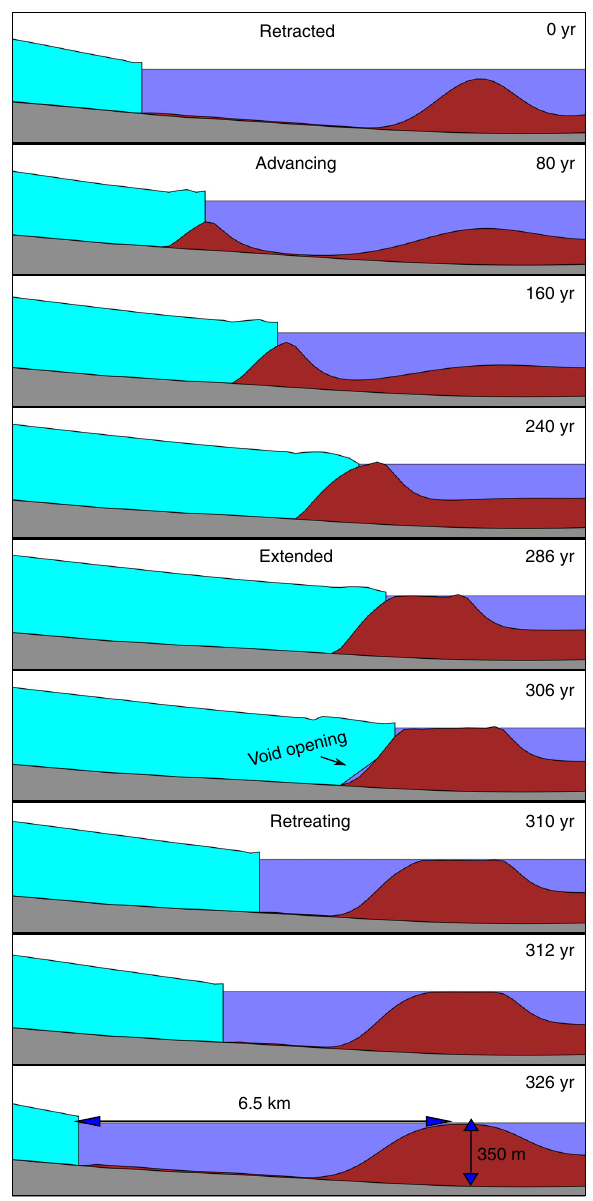
Fig. 3 Modeled glacier geometry through a tidewater glacier cycle. Time period corresponds to the shaded interval in Fig. 4. Cyan represents ice, blue water, brown sediment, and gray bedrock. At each stage, the model solves the equations of ice and sediment motion described in “ Methods ” . The panels are not uniformly distributed in time, due to the asymmetric time scales of advance and retreat. At t = 0 year the glacier is retracted, then advances until t = 286years. At t = 306 years, fl uvial erosion thins the shoal ’ s upstream end causing the glacier to come a fl oat. The beginning of this process is evident in the small void developing at the upstream end of the shoal. Over the next 20 years, the glacier retreats towards